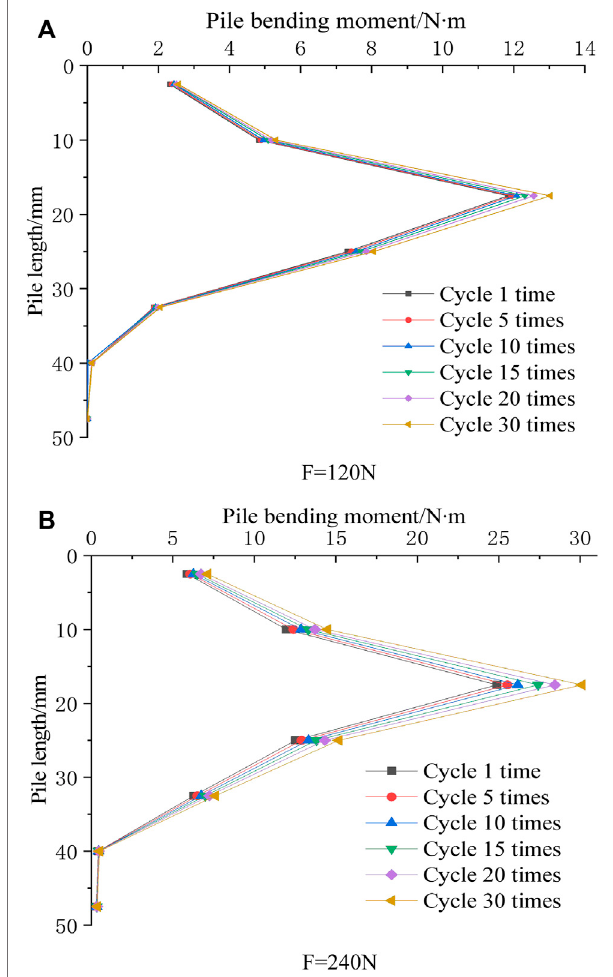
FIGURE 17 | Bending moment distribution diagram of composite foundation pile under horizontal cyclic load. (A) Bending moment distribution diagram at F = 120N. (B) Bending moment distribution diagram at F =